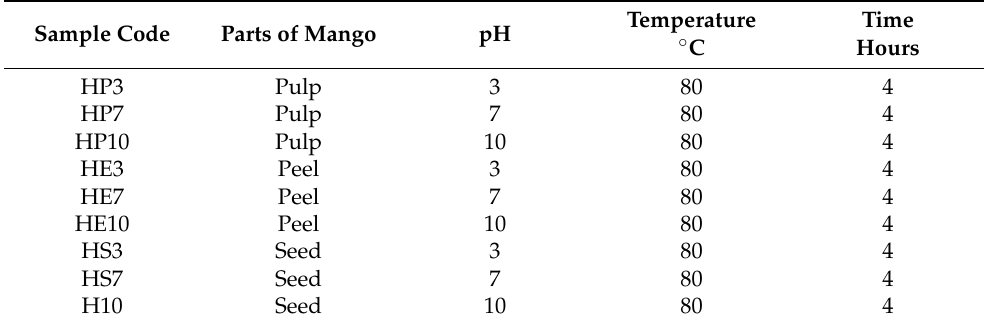
Table 4. Extraction conditions of hydrocolloids from pulp, peel, and seed from mango ( Mangifera in- dica ) var.